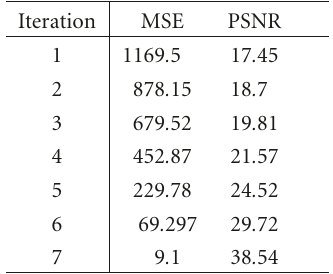
Table 5: Reconstructed image quality using proposed asymmetric turbo code without interleaver over AWGN